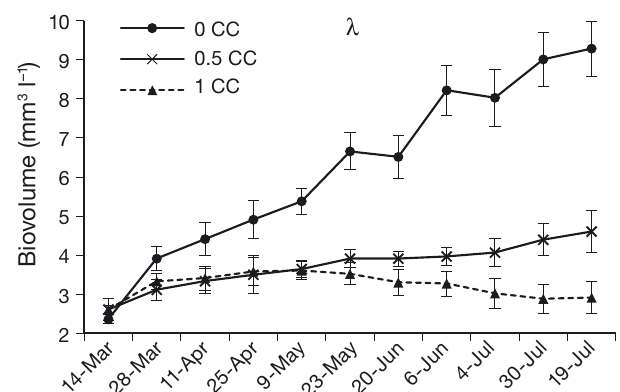
Fig. 3. Interaction between time and common carp (CC; Cyprinus carpio) density on the changes of benthic macroin- vertebrate biovolumes in the pond sediment. Data are means (±SE). 0 CC, 0.5 CC and 1 CC indicate the ponds without common carp, with 0.5 common carp m −2 , and with 1 common carp m −2 , respectively. λ indicates that the ponds without common carp, with 0.5 common carp m −2 , and with 1 common carp m −2 are significantly different from each other (p < 0.05)